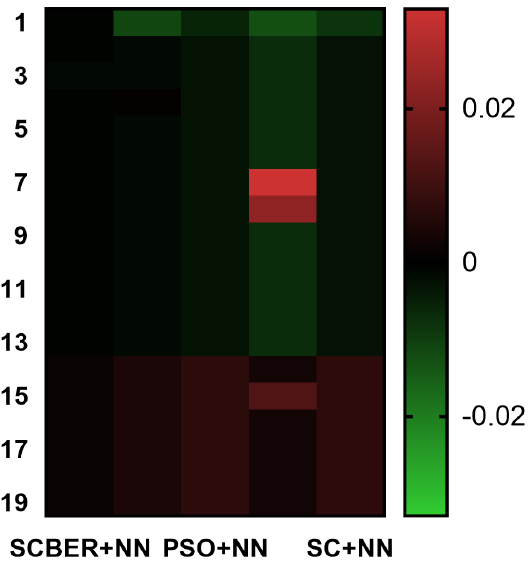
Figure 15. The accuracy plot and accuracy histogram plot of the results achieved by the proposed SCBER algorithm, and four other optimization algorithms. ( a ) Accuracy plot. ( b ) Histogram plot.